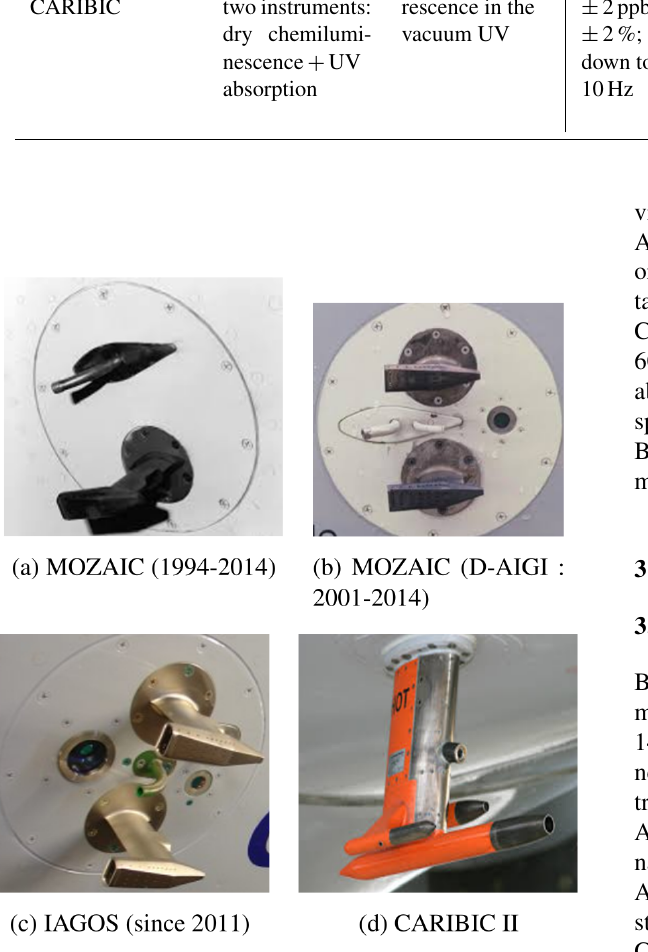
Figure 3. Pictures of the inlet plates used throughout the various programs. In panels (a) , (b) and (c) , air for O 3 and CO measure- ments is collected through the small forward-facing pitot tube. In panel (c) , it is done using the lowest small inlet. Other inlets and Rosemount pitots are for water, aerosol or other gas measurements. The inlet shown in panel (b) was installed on one MOZAIC air- craft (D-AIGI) with an additional Rosemount inlet for NO y / NO x measurements. It is the precursor of the IAGOS